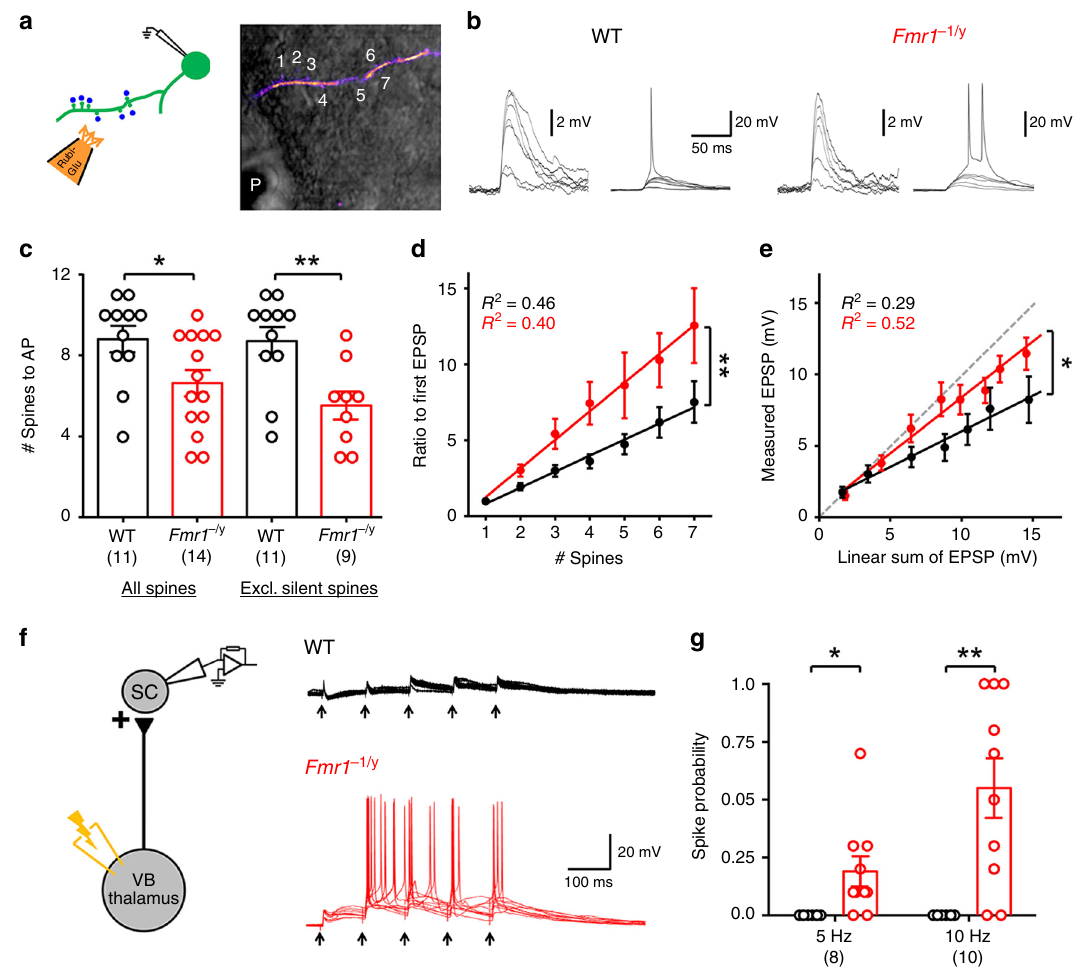
Fig. 9 Enhanced dendritic integration of L4 SCs in Fmr1 − /y mice. a Schema of near-simultaneous glutamate uncaging (Rubi-Glu) at multiple spines (blue dots/numbers). b Near-simultaneous glutamate uncaging produced subthreshold (inset, right) and suprathreshold uEPSPs (inset, left) along dendrites. c The number of spines required to evoke an AP, from all spines (left; WT: 8.8 ± 0.7; Fmr1 − /y ; 6.6 ± 0.6) and excluding “ silent spines ” (right; WT: 8.7 ± 0.7; Fmr1 − /y ; 5.6 ± 0.7). d Summation of near-simultaneous subthreshold uEPSPs normalized to the fi rst EPSP in WT (black) and Fmr1 − /y (red) L4 SCs (Slope: WT: 1.1 ± 0.13; Fmr1 − /y ; 1.9 ± 0.2; d.f.: 1, 170; F = 8.98; p = 0.003; F-test). e Summating uEPSPs plotted against the expected linear sum. Unity is indicated (grey). f Electrical stimulation of TCA at low frequency 10 Hz is shown. g Average spike probability in response to 5 and 10 Hz stimulation. Statistics shown: * p < 0.05, ** p < 0.01. All data are shown as mean ± SEM and source data for all plots are provided as a Source Data fi